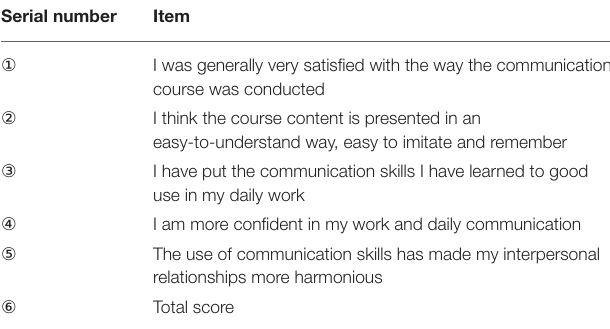
TABLE 5 | Communication training satisfaction scale of new